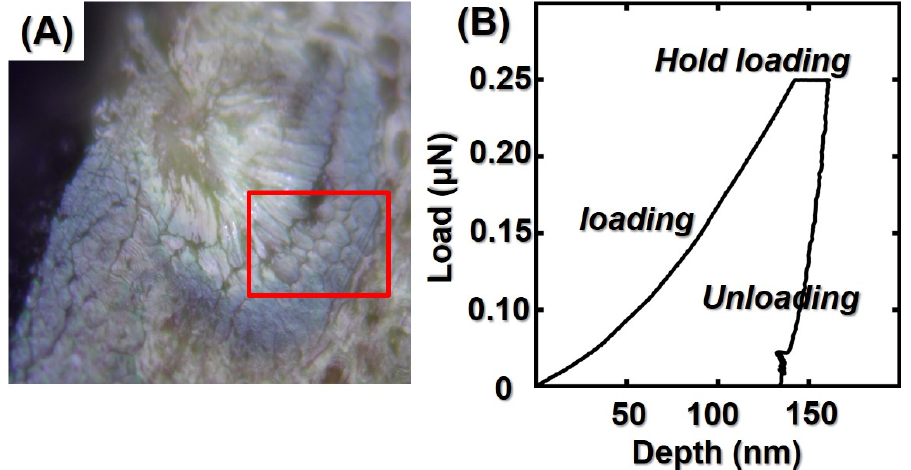
Figure 3. ( A ) Test location of bamboo cell walls; ( B ) typical nanoindentation (NI) load–depth curves.